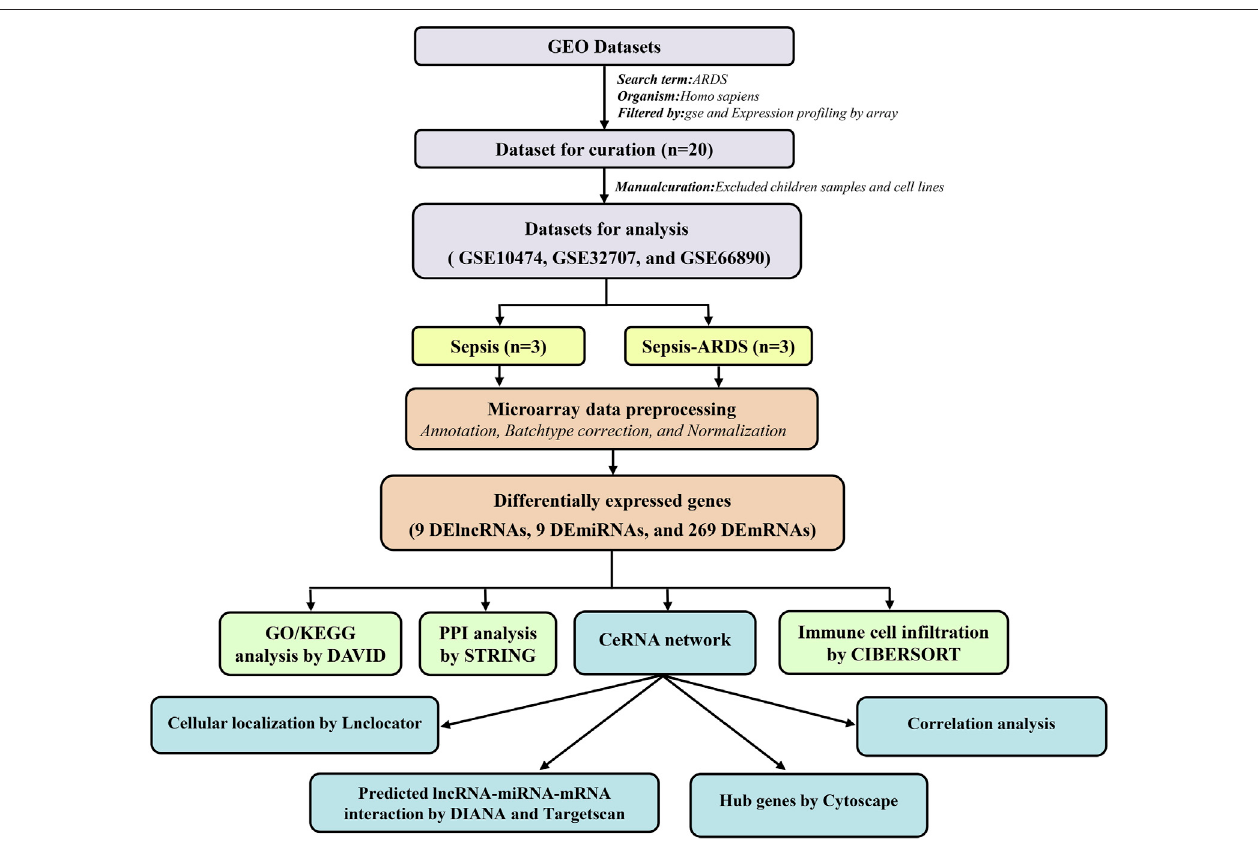
FIGURE 1 | Summary of the work fl ow adopted in this work.